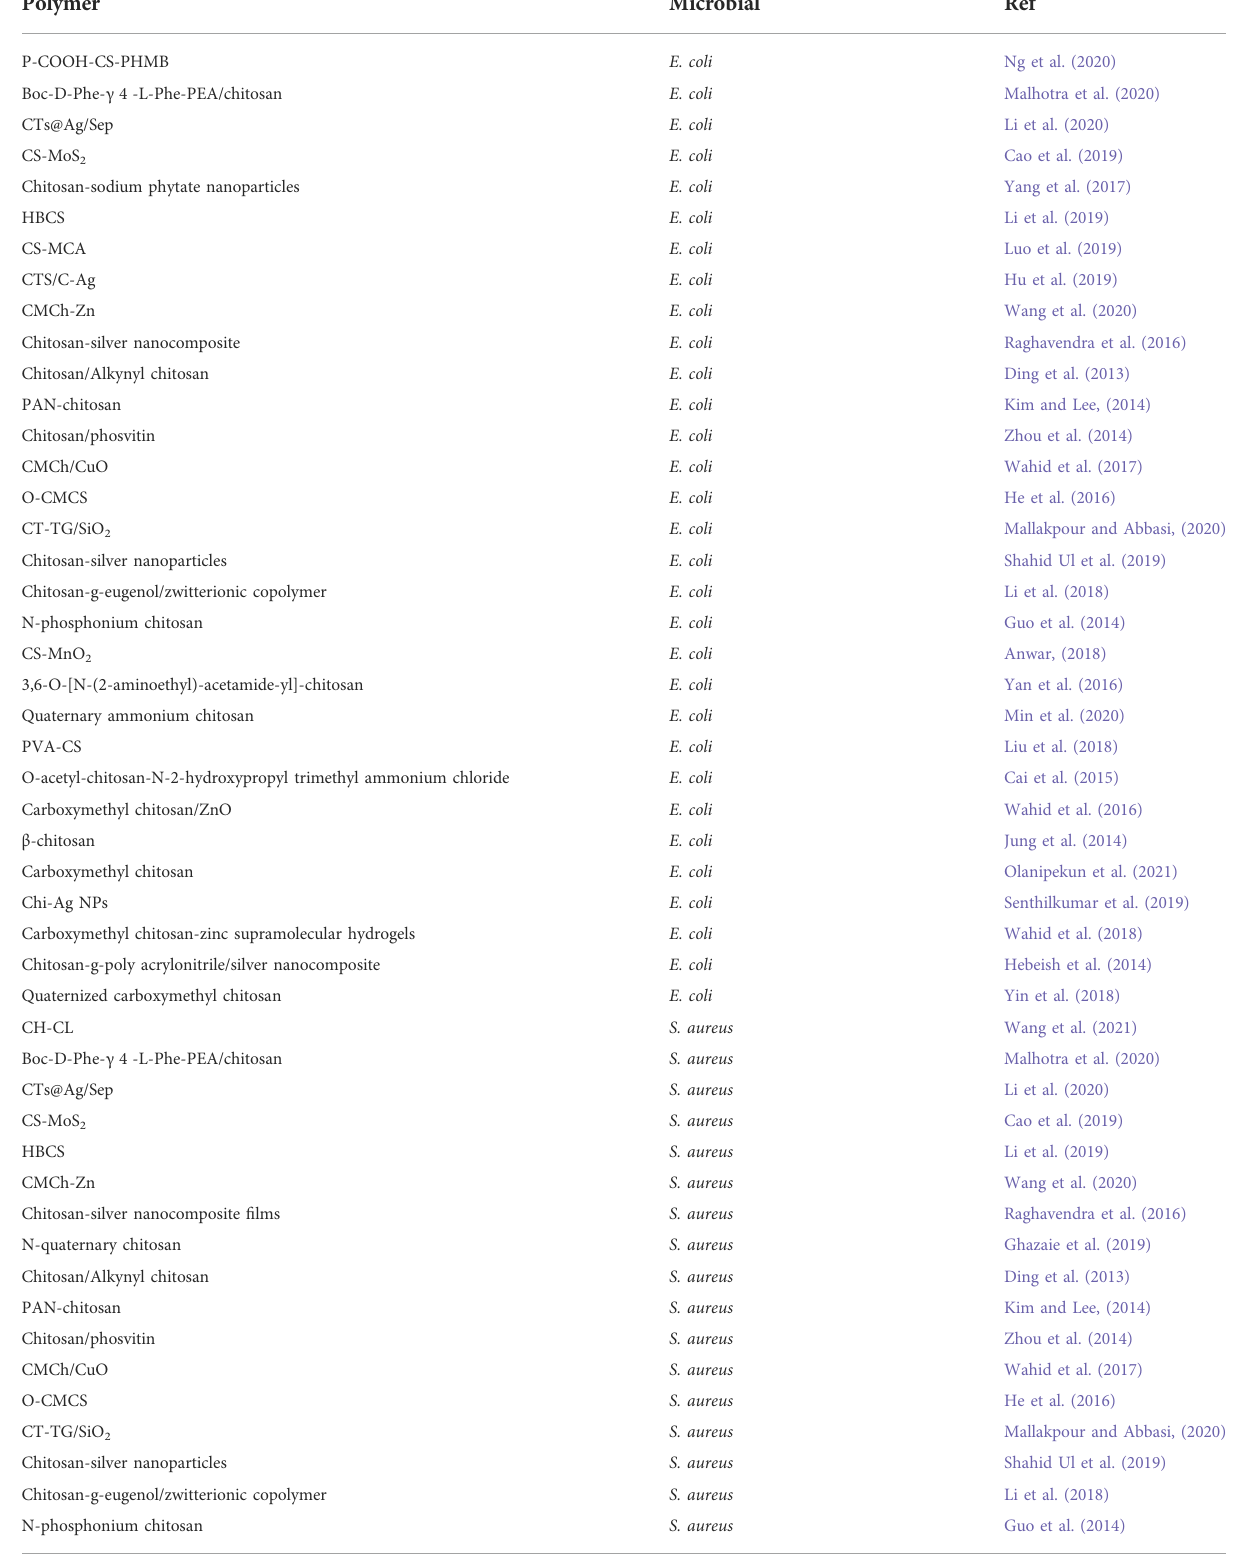
TABLE 1 Antibacterial effect of chitosan and its derivatives on different microorganisms. Polymer